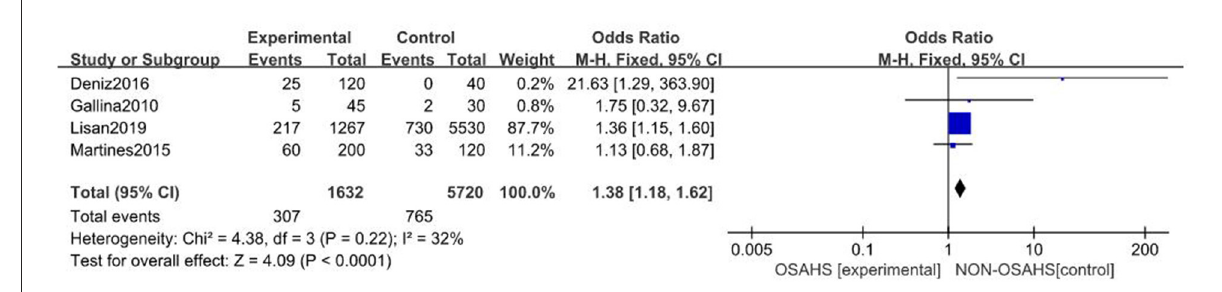
FIGURE2 Forest plot of correlation between the incidence of hearing loss in OSAHS group and control group.